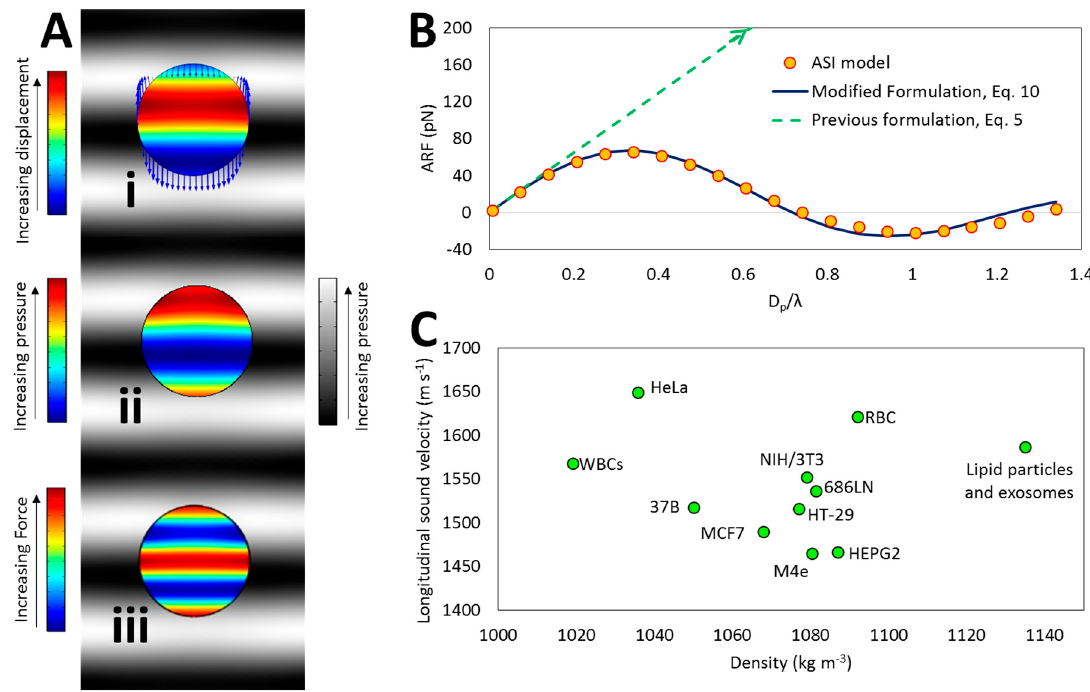
Figure 3. Analysis of the ARF exerted on the BP using ASI simulation. ( A ) Color map of displacement (i), internal pressure ((ii) (cid:1868) (cid:3046)(cid:3042)(cid:3039)(cid:3036)(cid:3031) = ((cid:2026) (cid:2869)(cid:2869)(cid:3046) + (cid:2026) (cid:2870)(cid:2870)(cid:3046) + (cid:2026) (cid:2871)(cid:2871)(cid:3046) )/3 , in which (cid:2026) (cid:3036)(cid:3036)(cid:3046) is the i -th principle stress in the solid domain), and time-averaged force on the elements within the BP (iii). The BP is placed in an acoustic standing pressure field (gray scale) with λ = D p . In high frequencies, the elements located in various positions within the BP experience different displacements due to gradients of the pressure. Thus, the BP cannot be considered as a single point, and the resultant force over the whole BP volume needs to be calculated to obtain the ARF; ( B ) The comparison between the results of ASI model, proposed formulation (Equation (10)) in present work and previous formulations (Equation (5)). Results show a significant deviation of the ARF values in high frequencies between Equation (5) predictions and ASI results, however the proposed formulation (Equation (10)) is in a good accordance with the ASI model; ( C ) Density and longitudinal sound velocity of some BP materials [4,6,20,38,44,45]. Since deriving Equation (10) is based on the negligible difference in pressure map inside and outside the BP, the closeness of acoustic impedance of BP and surrounding fluid warrants a negligible error for the proposed formulation (see also Section